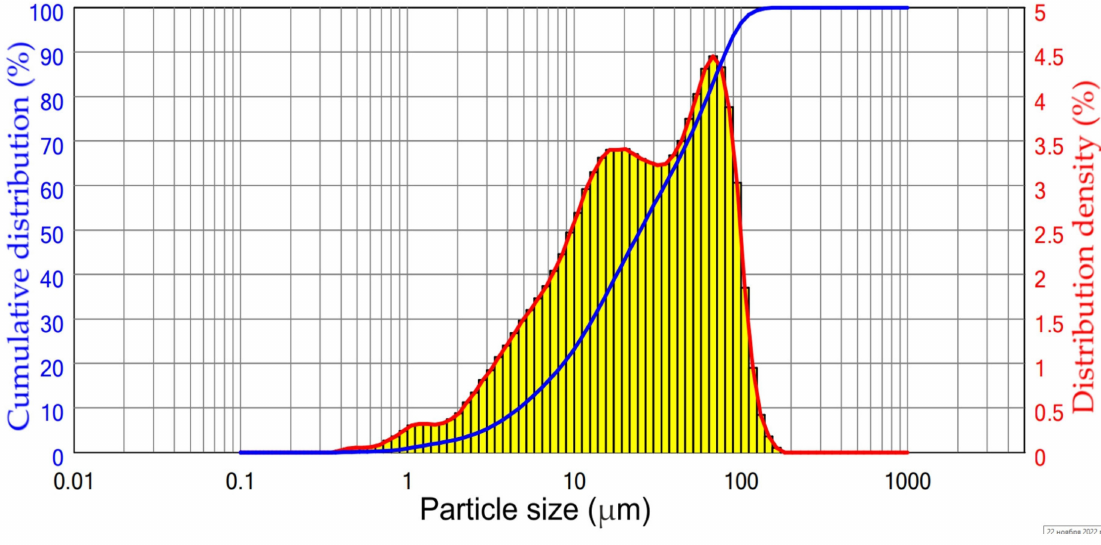
Figure 1. The particle size distribution of the raw CFA. Table 1. Chemical composition of the raw CFA. Main Components,